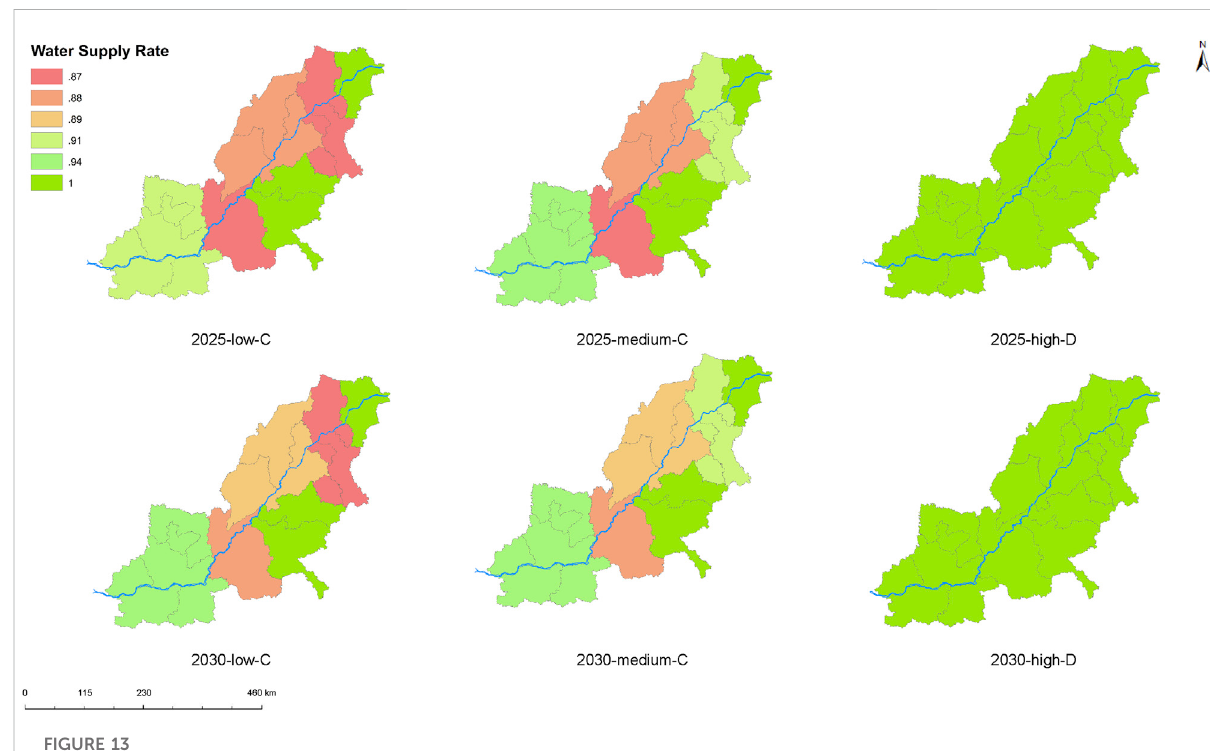
FIGURE 13 Overall water supply rate in study area in six